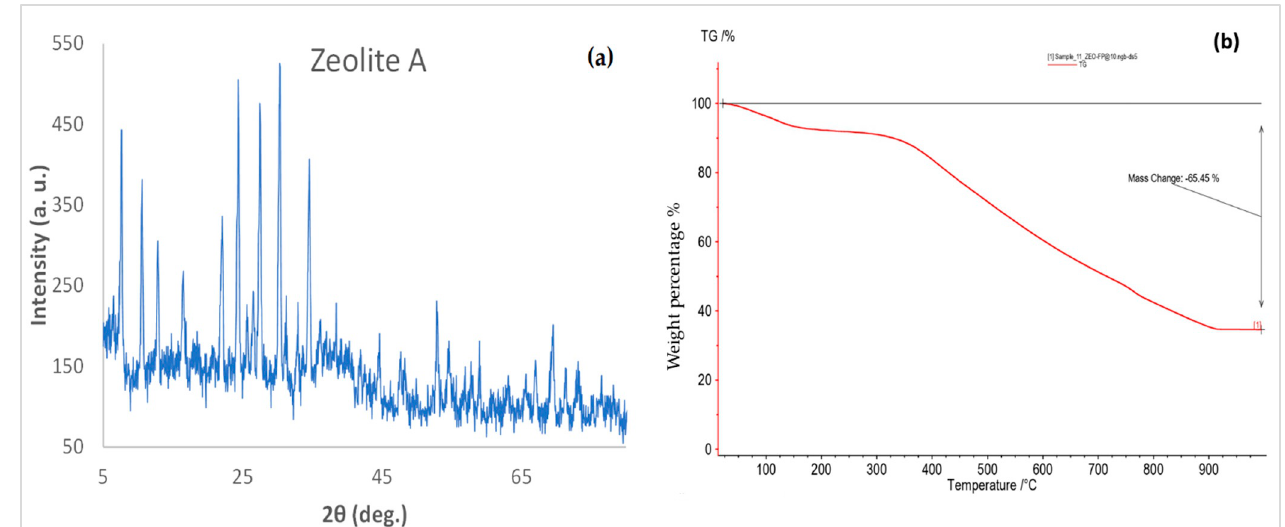
Figure 1. XRD diffractogram of zeolite A ( a ) and TGA thermographs analysis of Zeo-FPT composite ( b ). Table 2. FTIR spectroscopy absorption bands of Zeo, FPT, and the Zeo-FPT composite Wave Number Stretching cm − 1